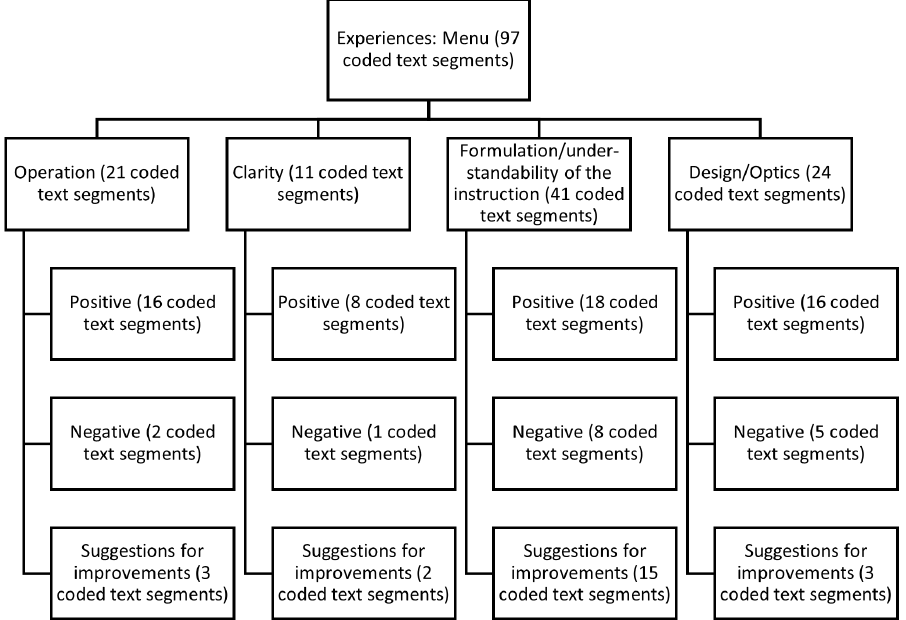
Figure 11. Summary representation of the focus group interviews based on the coded text segments related to the user